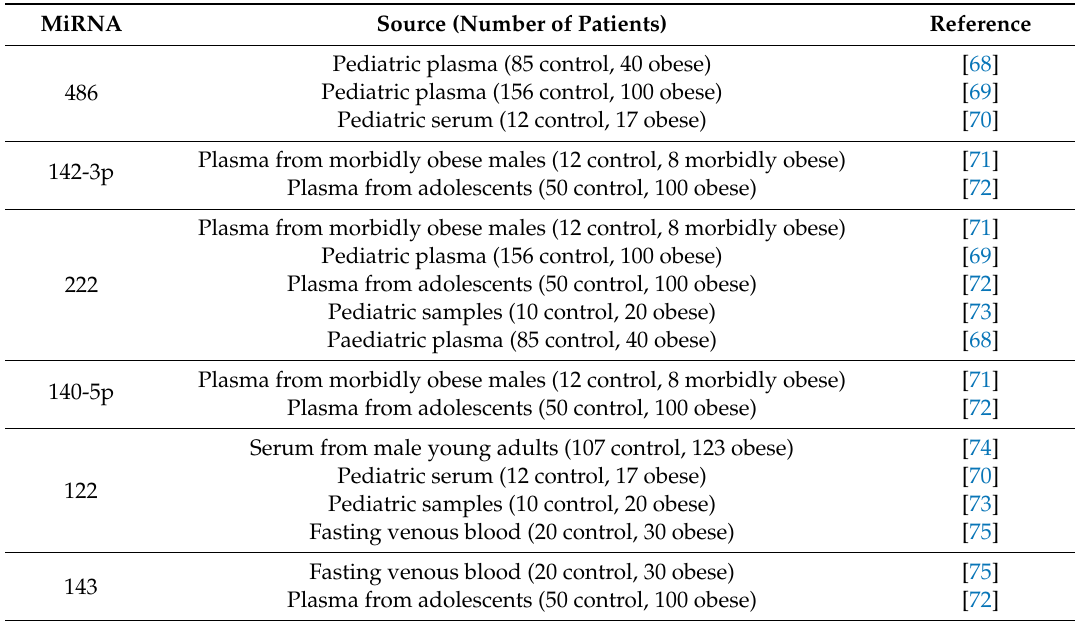
Table 1. Circulating microRNAs (miRNAs) which were reproducibly increased in obesity. MiRNA